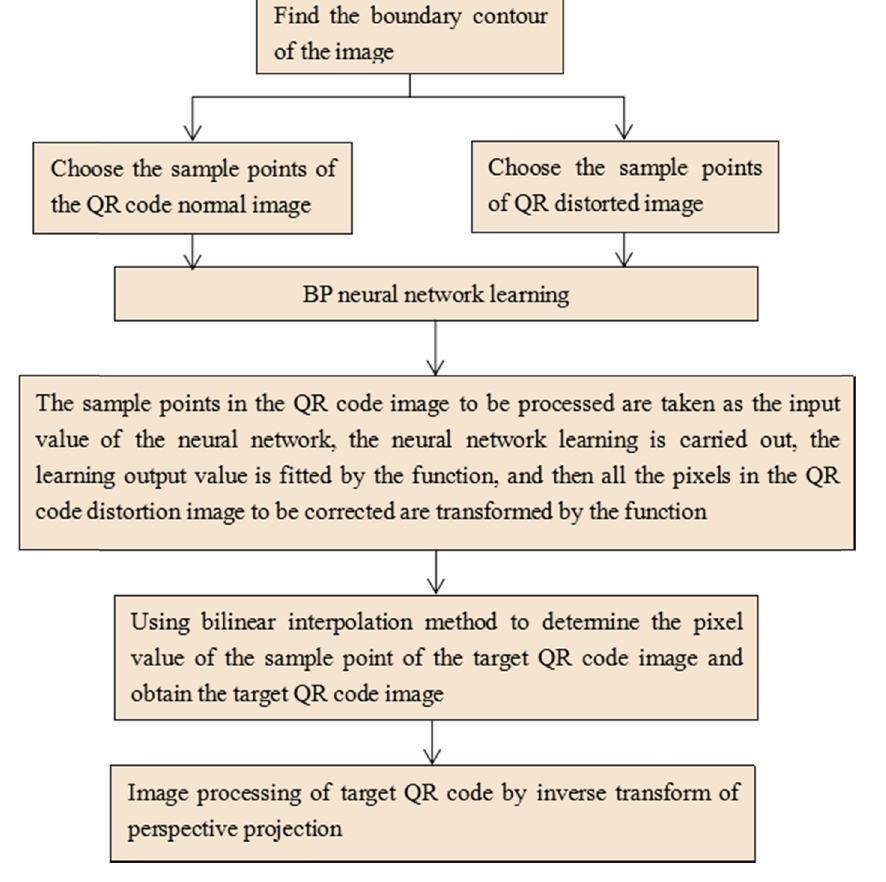
Figure 5: Flow chart of QR image processing with the BP neural